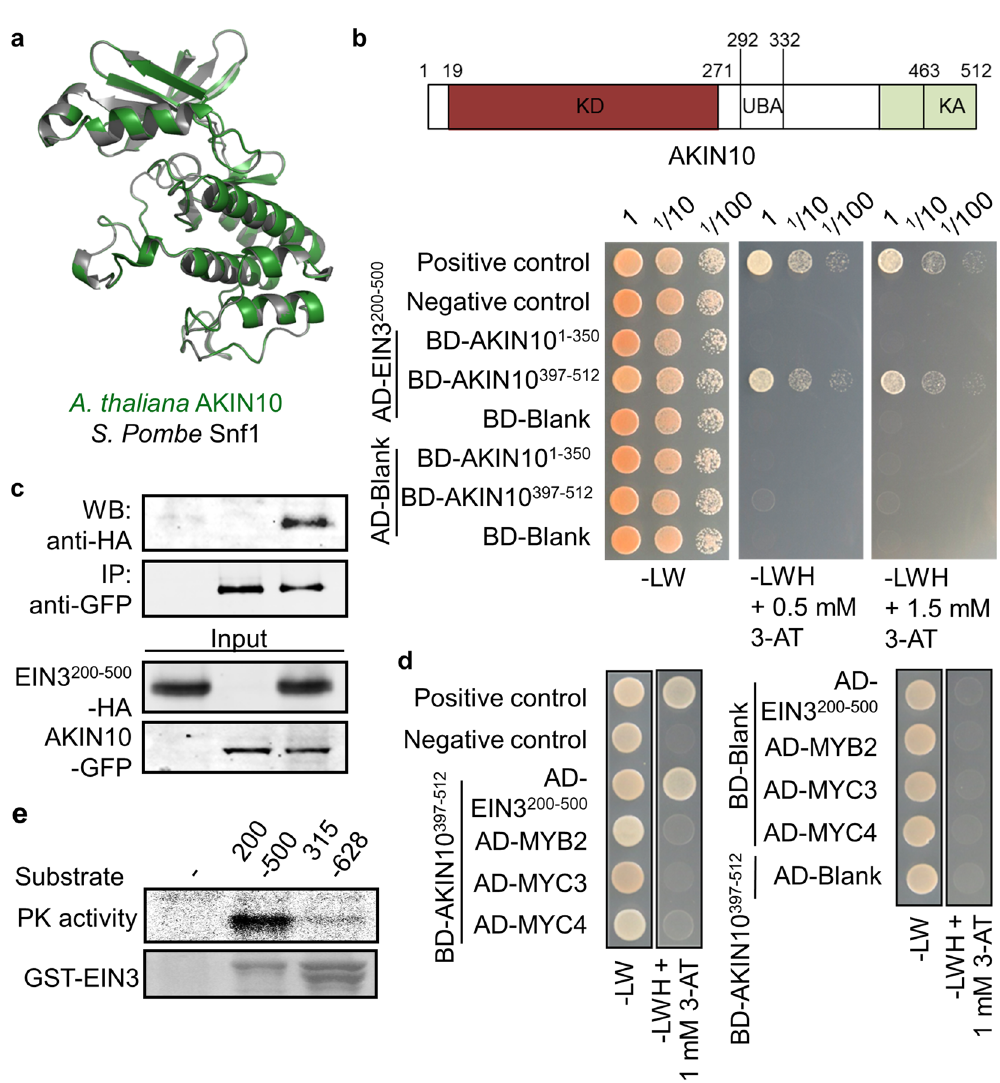
EBSp-fLUC reporter activity was induced by EIN3 expression, but the EIN3-dependent induction of EBSp-fLUC activity was suppressed in the presence of DCMU (Fig. 2b), indicating DCMU enables to repress EIN3-dependent gene expression. As previously reported 21, 24 , DIN6p-fLUC reporter activity was induced by wild-type (WT) AKIN10 (AKIN10 WT ), but not by the kinase inactive form of AKIN10 (AKIN10 IN ) that replaces Lys48 with Met. Moreover AKIN10-inducible DIN6p-fLUC activity was a little further enhanced by EIN3 co-expression, even though it was not induced by EIN3 alone (Fig. 2c). EBSp-fLUC reporter activity was not altered by either AKIN10 WT or AKIN10 IN alone and only induced by EIN3 expression (Fig. 2d). However, the induction of EIN3-dependent reporter activity was diminished by AKIN10 WT co-expression (Fig. 2d) in a manner similar to DCMU (Fig. 2b), but not by AKIN10 IN . These results suggested that AKIN10 activation leads to the suppression of EIN3-dependent gene expression. To understand how AKIN10 suppresses EIN3-inducible reporter activity, EIN3 protein stability regulation was examined as a putative functional mode of AKIN10. The short-lived EIN3 protein level was monitored